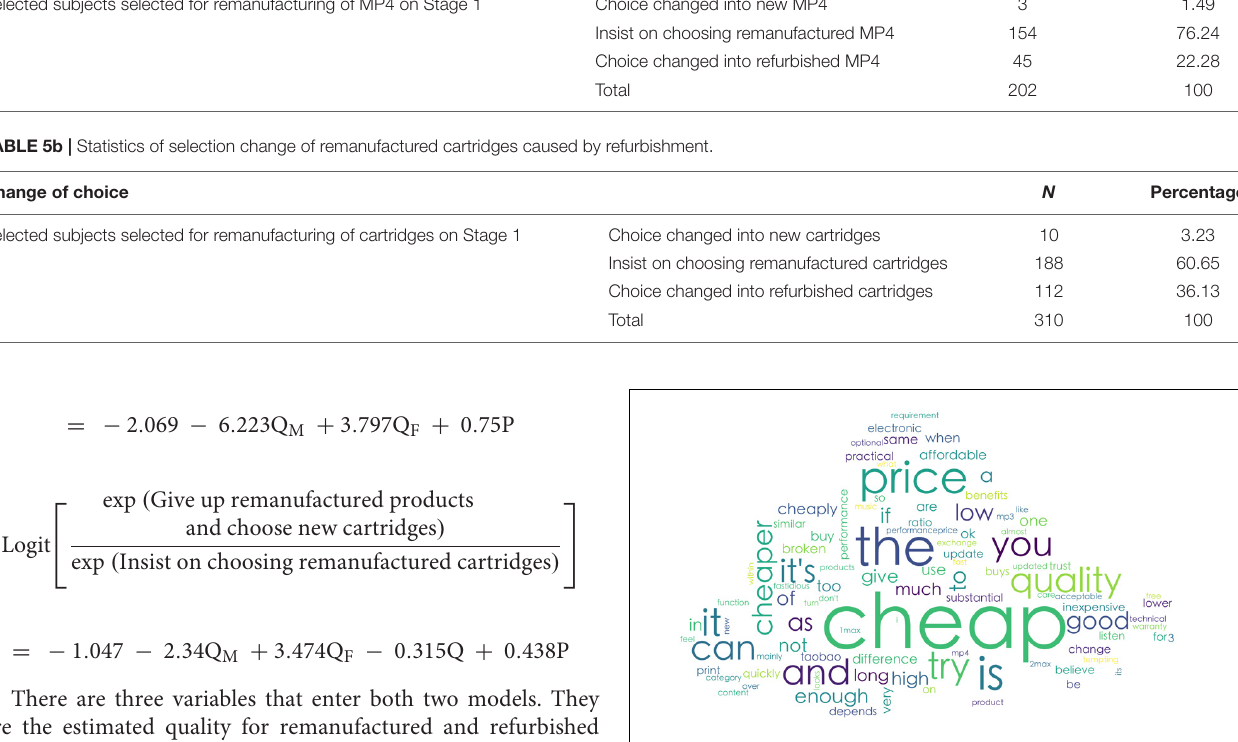
FIGURE 3 | Reasons for choosing refurbished